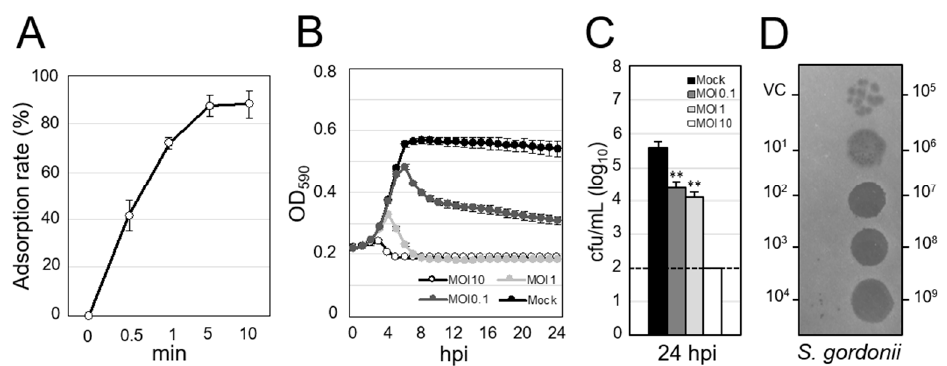
Figure 2. Lytic activity of Φ SG005 against S. gordonii ATCC10558. ( A ) Adsorption rate of Φ SG005 on